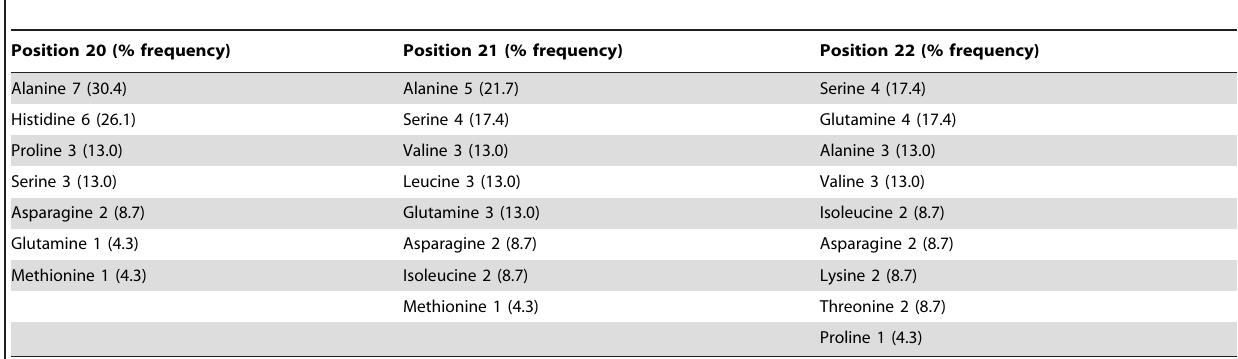
Table 4. Frequency with which amino acids are located at each hinge site among the derivatives presented in Table 3.